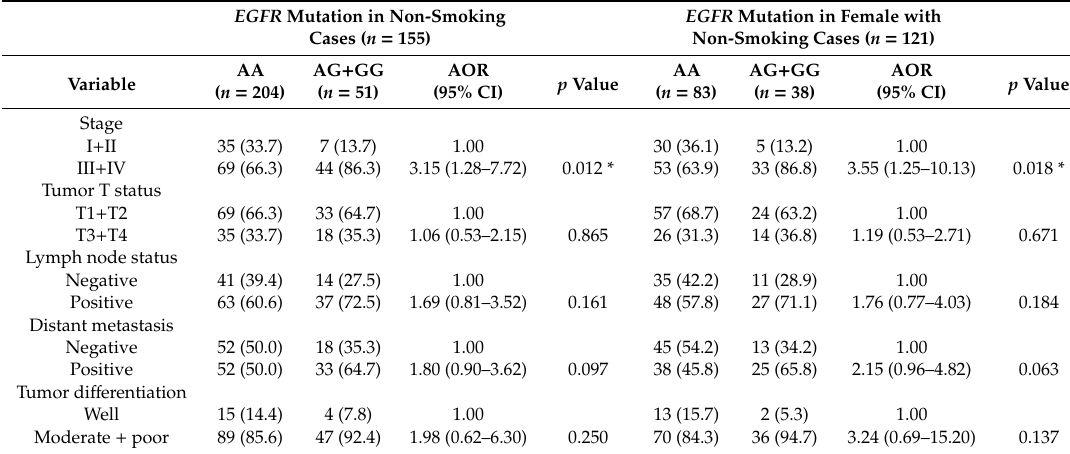
Table 5. Clinicopathologic characteristics of lung adenocarcinoma patients with EGFR mutation in non-smoking population, stratified by polymorphic genotypes of SOD